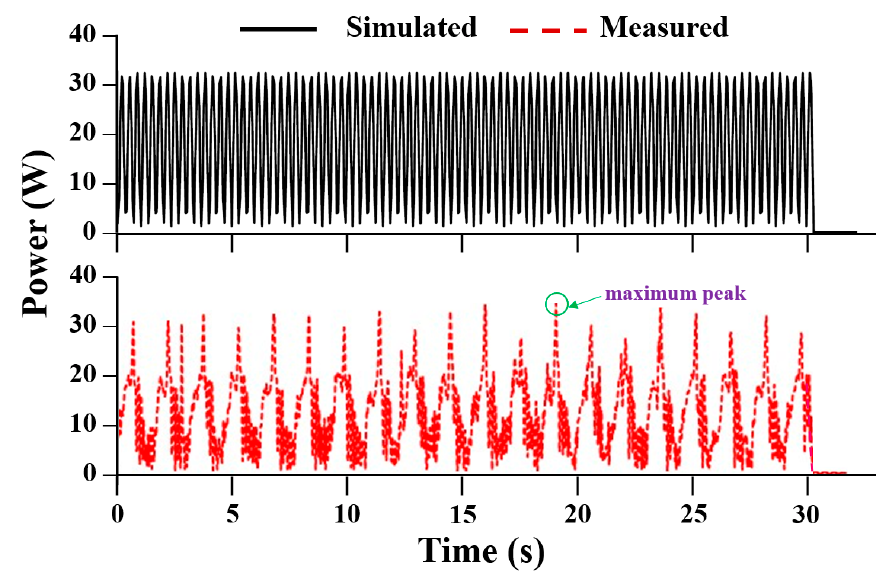
Figure 12. Simulated and measured power requirement (W) at 60 rpm as a function of time